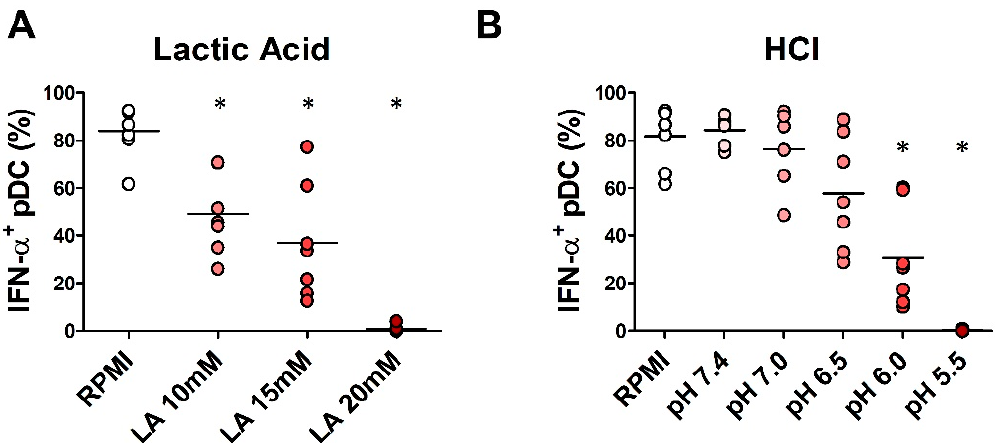
Figure 4. In vitro lactic acidosis affects IFN- α production by pDCs. pDCs purified from buffy coats of HD were cultured in RPMI 1640 medium supplemented with 10% FBS and IL-3 plus lactic acid (10 mM; 15 mM; 20 mM) ( n = 7; ( A )) or hydrochloric acid (pH = 7.4; 7.0; 6.5; 6.0; 5.5) ( n = 7; ( B )) for 24 h. pDCs were stimulated with R848 for 2 h. Intracellular IFN- α was analyzed by flow cytometry. Aligned dot plot graphs show the percentages of IFN- α + pDCs evaluated on BDCA-2 + / CD123 + cells. Bars represent the mean of biological replicates. The statistical significance was calculated by two-sample paired sign test. * p < 0.05.